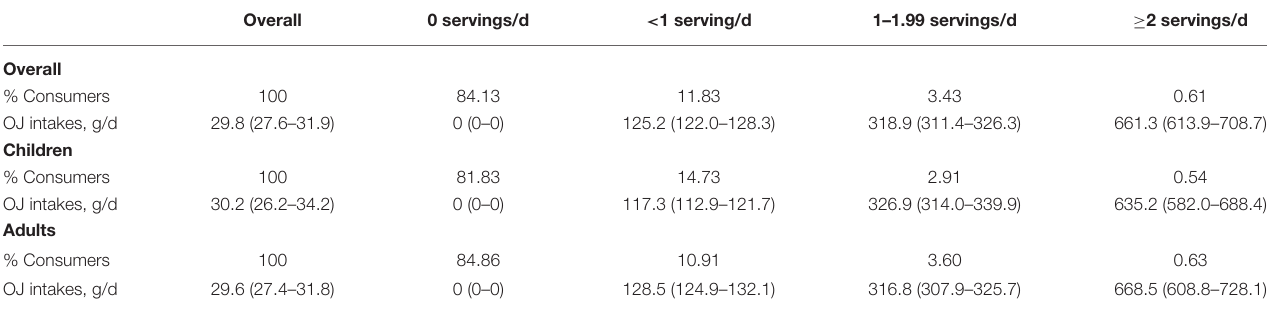
TABLE 3 | Average orange juice consumptions and percentage of individuals consuming 0 servings, < 1 serving, 1–1.99 servings, or at least two servings per day of orange juice.